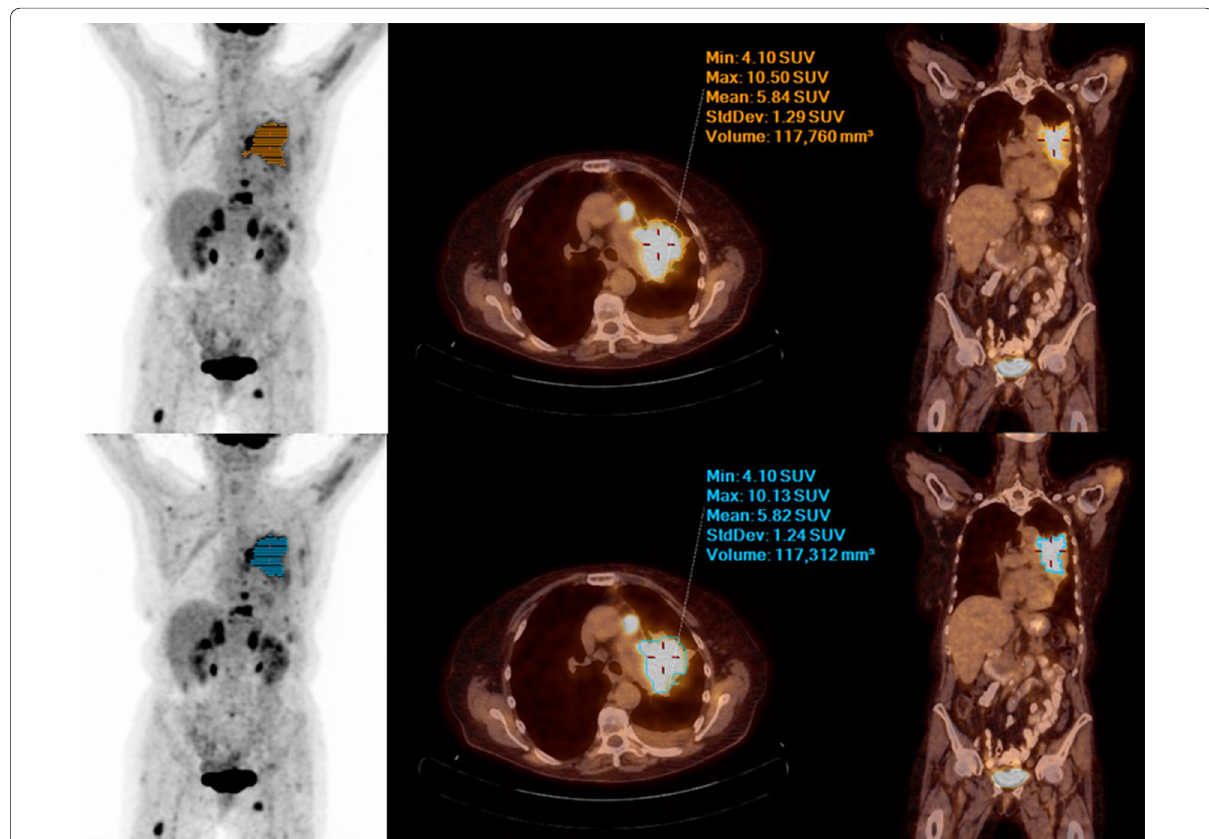
Fig. 1 MIP, fused axial and coronal PET/CT images (from left to right) with 75 s (upper row )and 57 s (lower row) PET acquisition time per bed position of a 71‑year‑old female patient with 65 kg bw suffering from lung cancer—no significant difference in image quality, lesion